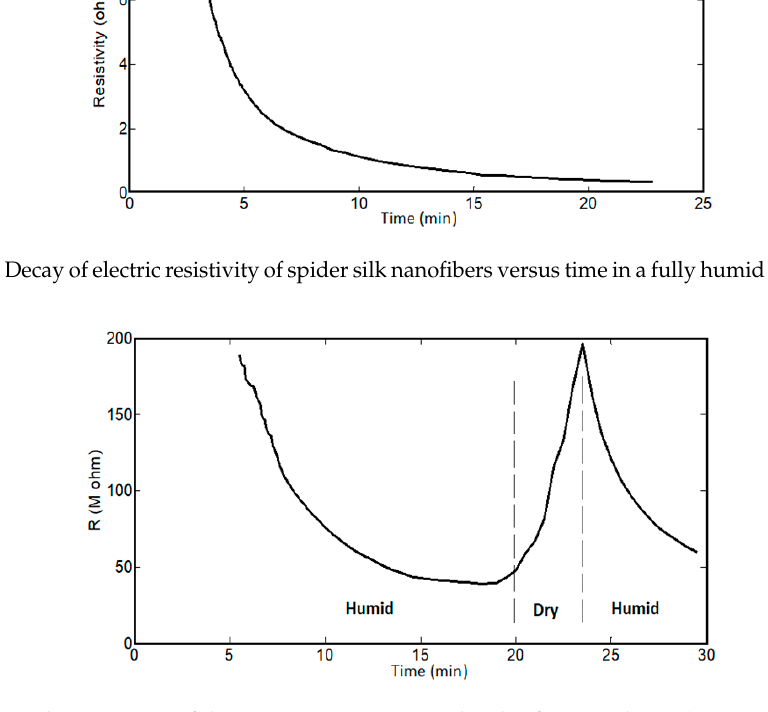
Figure 13. Decay of electric resistivity of spider silk nanofibers versus time in a fully humid environment.